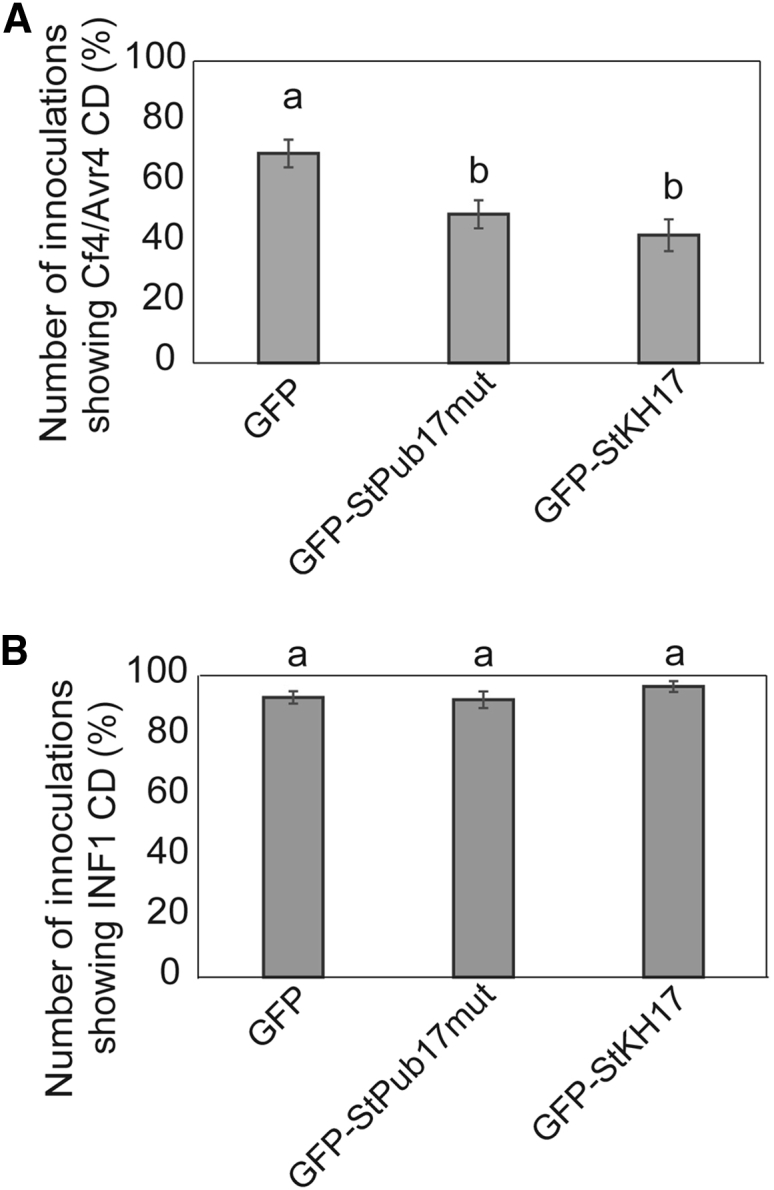
StKH17 Overexpression Suppresses Cf4/Avr4 CD but Not INF1-Triggered CD.(A) Overexpression of either GFP-StKH17 or the dominant-negative GFP-StPUB17mut constructs is able to significantly reduce cell death triggered by the recognition of C. fulvum Avr4 by tomato Cf4 compared to the overexpression of free GFP (ANOVA p ≤ 0.009, N = 24). The combined data are shown for three biological replicates comprising eight N. benthamiana plants per replicate.(B) Overexpression of either GFP-StKH17 or the dominant-negative GFP-StPUB17mut constructs has no effect on cell death triggered by the P. infestans PAMP INF1 compared to the overexpression of free GFP (ANOVA p = 0.34, N = 24). The combined data are shown for three biological replicates comprising eight N. benthamiana plants per replicate.Error bars are SE; lowercase letters indicate significant differences tested by one-way ANOVA with pairwise comparisons performed using the Holm-Sidak test.